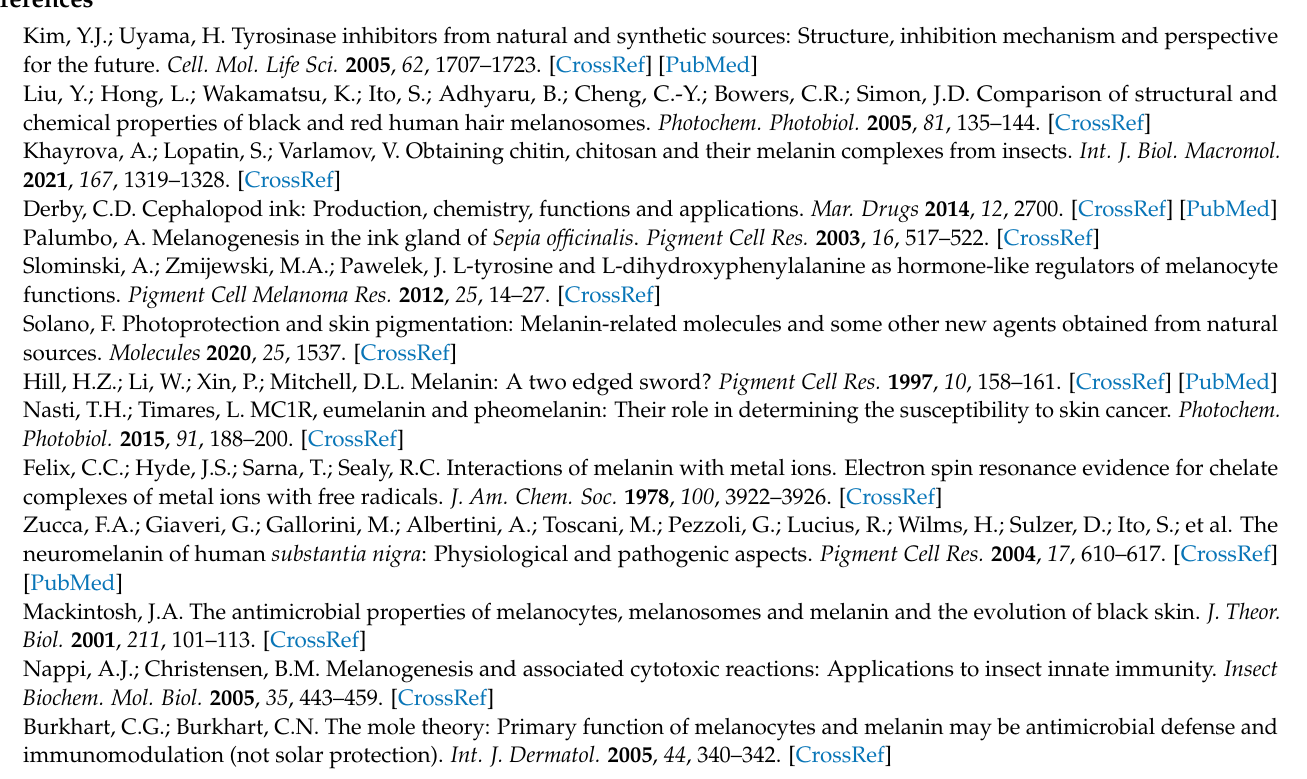
Figure S3: Fitting analysis of emission spectra recorded from black cat hairs (A) and from mosquito eggs